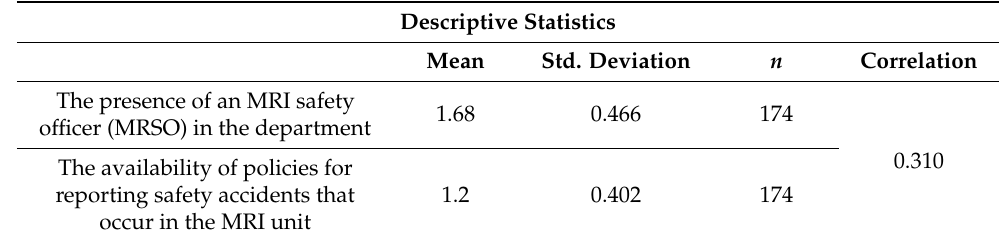
Table 6. The relationship between the presence of an MRSO in the department and the availability of policies for safety accident